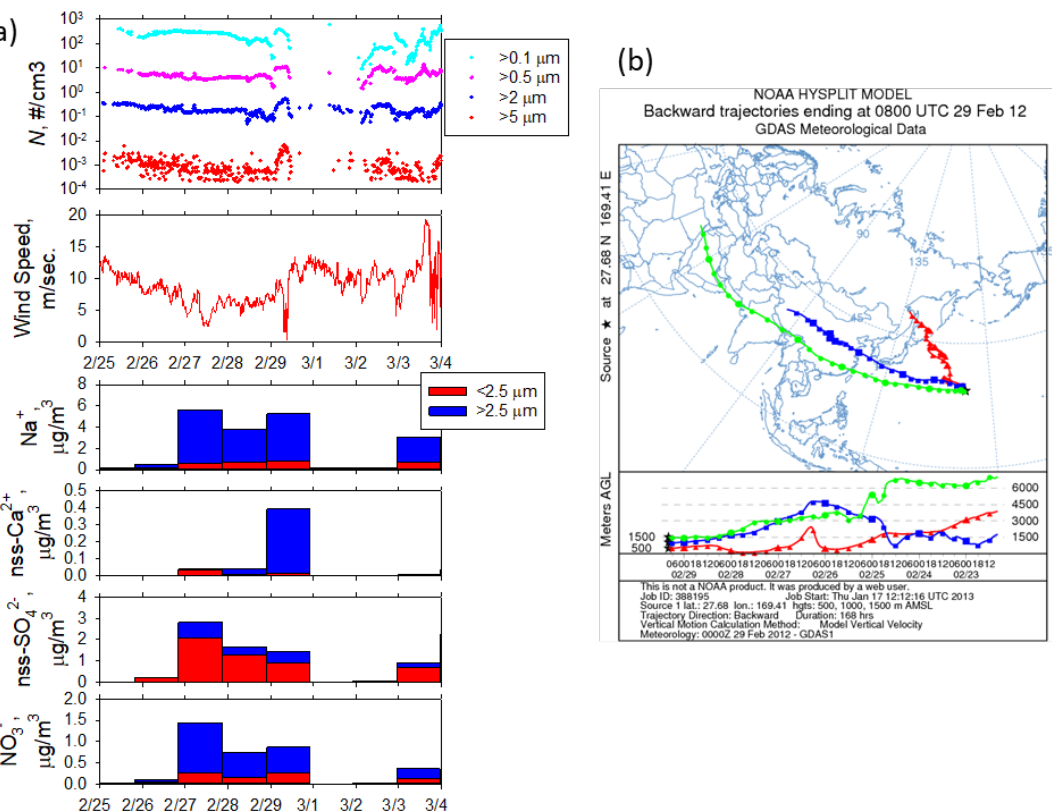
Figure 1. ( a ) Temporal variations of aerosol number concentration ( N ), wind speed, and concentrations of Na + , nss-Ca 2 + , nss-SO 42 + , and NO 3 − . ( b ) 168 h horizontal backward trajectories for the dust event on February 29, 2012. The trajectories represented by the red, blue, and light green lines were, respectively, calculated for altitudes of 500, 1000, and 1500 m above sea level.